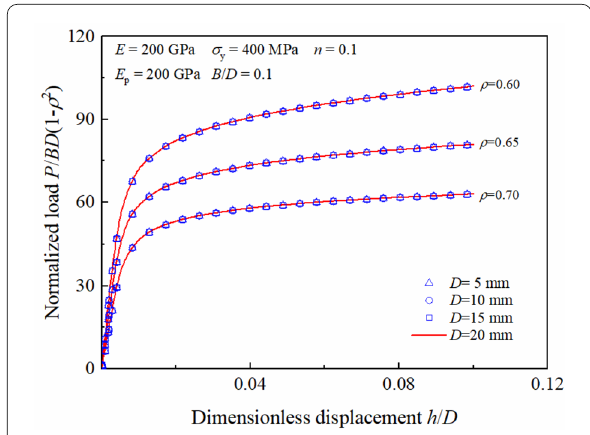
Figure 3 Normalized load–dimensionless displacement curves for various dimeters Figure 4 Unit thickness P – h curves for various B / D